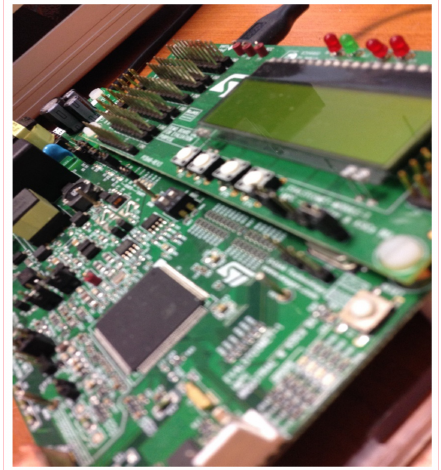
Figure 2. STMicroelectronics (ST) power-line communication (PLC) Evaluation smart meter board installed close-up with USB built-in debugging